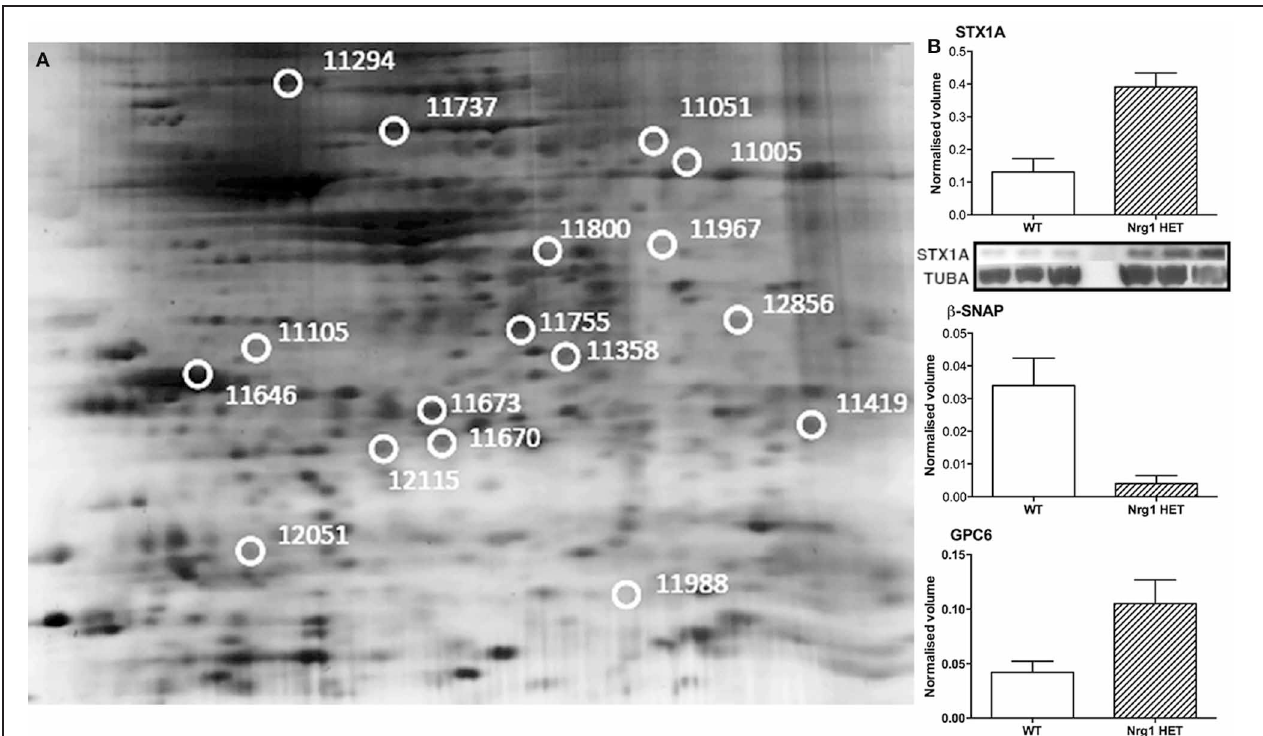
FIGURE 1 | Adolescent hippocampal proteomics comparing adolescent vehicle-treated WT and Nrg1 HET mice. (A) Representative 2DE gel images showing positions of significantly altered protein spots [the horizontal axis split by isoelectric point, vertical axis split by molecular weight; STX1A (spot 11755); TPH1 (spot 11967); β -SNAP (spot 11358);